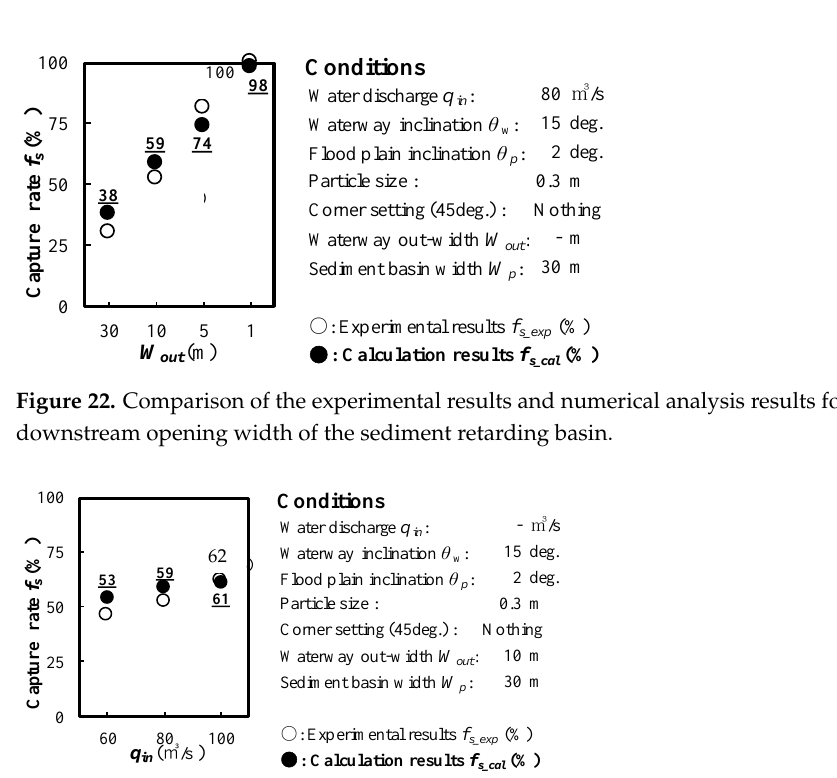
Figure 23. Comparison of the experimental results and numerical analysis results for changes in the supply flow rate.